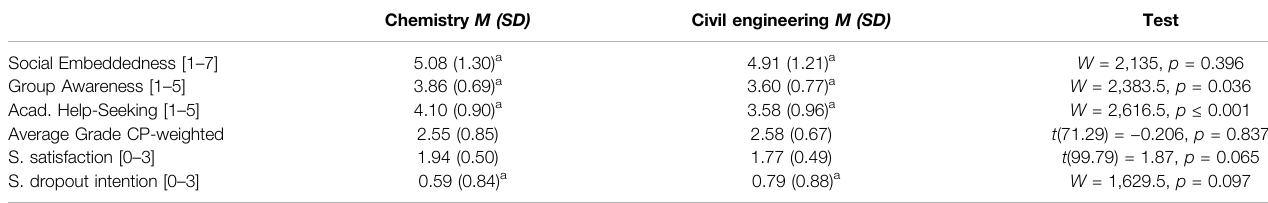
TABLE 2 | Descriptive statistics of dependent variables compared by study program.